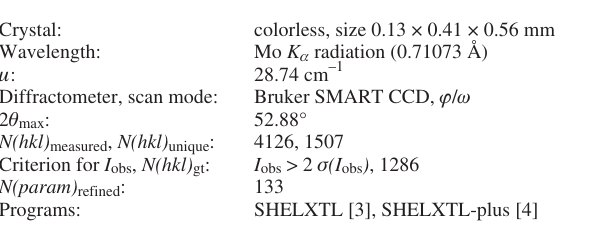
Table 1. Data collection and handling.